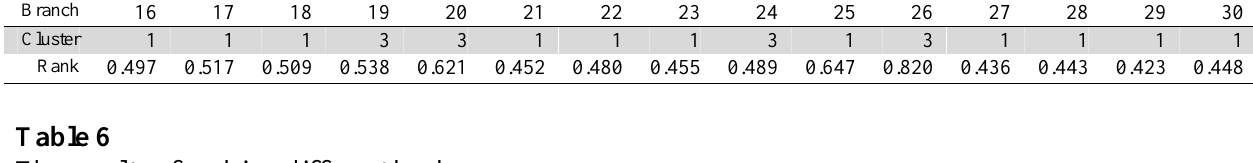
The results of ranking different banks